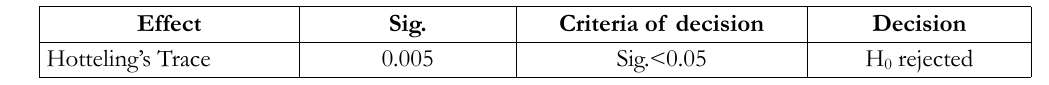
Table 15. Result of Hotteling’s Trace MANOVA Test